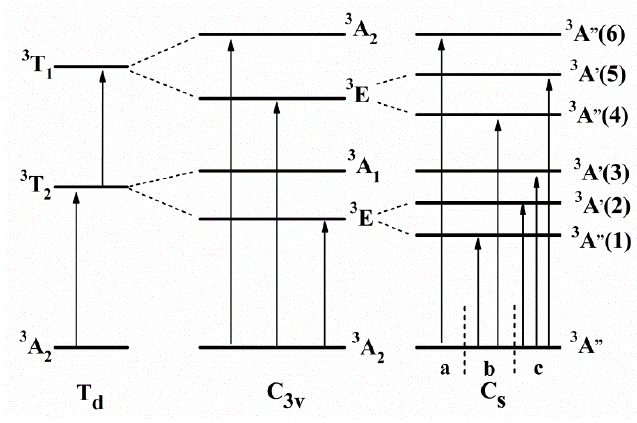
Figure 8. Energy level of the Cr 4+ ions.